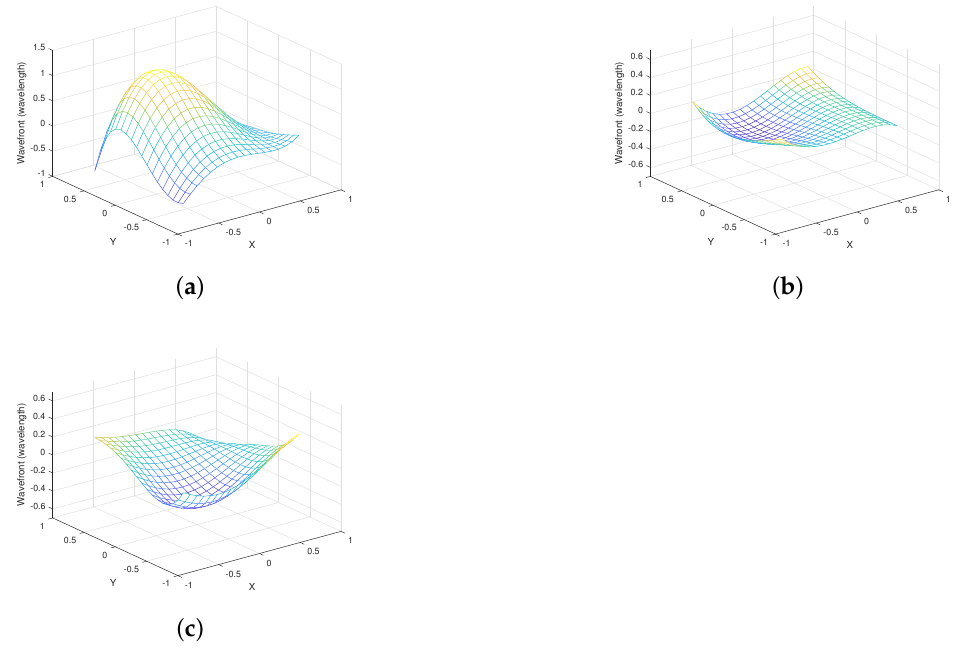
Figure 11. ( a ) Wavefront before compensation. ( b ) Wavefront compensated by proposed FSM-DM cascaded AO architecture with suggested algorithm. ( c ) Wavefront compensated by single DM AO architecture with traditional algorithm.